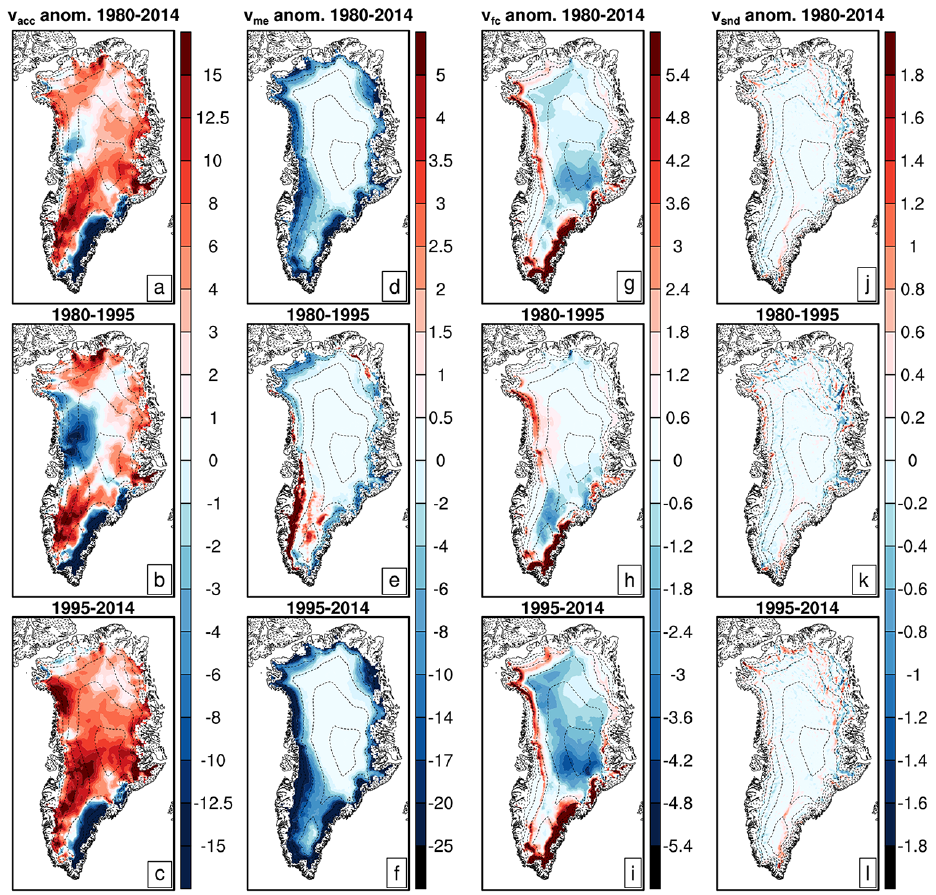
Figure 8. Anomaly of vertical velocity components with respect to the reference period 1960–1979 (in cmyr − 1 ). (a–c) Accumulation velocity v acc ; (d–f) melt velocity v me ; (g–i) firn compaction velocity v fc ; (j–l) snowdrift sublimation, erosion and deposition velocities ( v snd + v er ). Note that the colour scales for v me is strongly asymmetric around